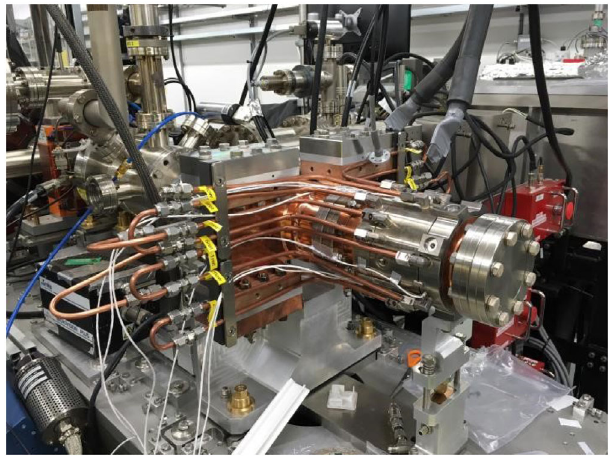
FIG. 19. 400 Hz photoinjector installed on the VELA beam line before the waveguide, cathode exchange system, and solenoids were installed.